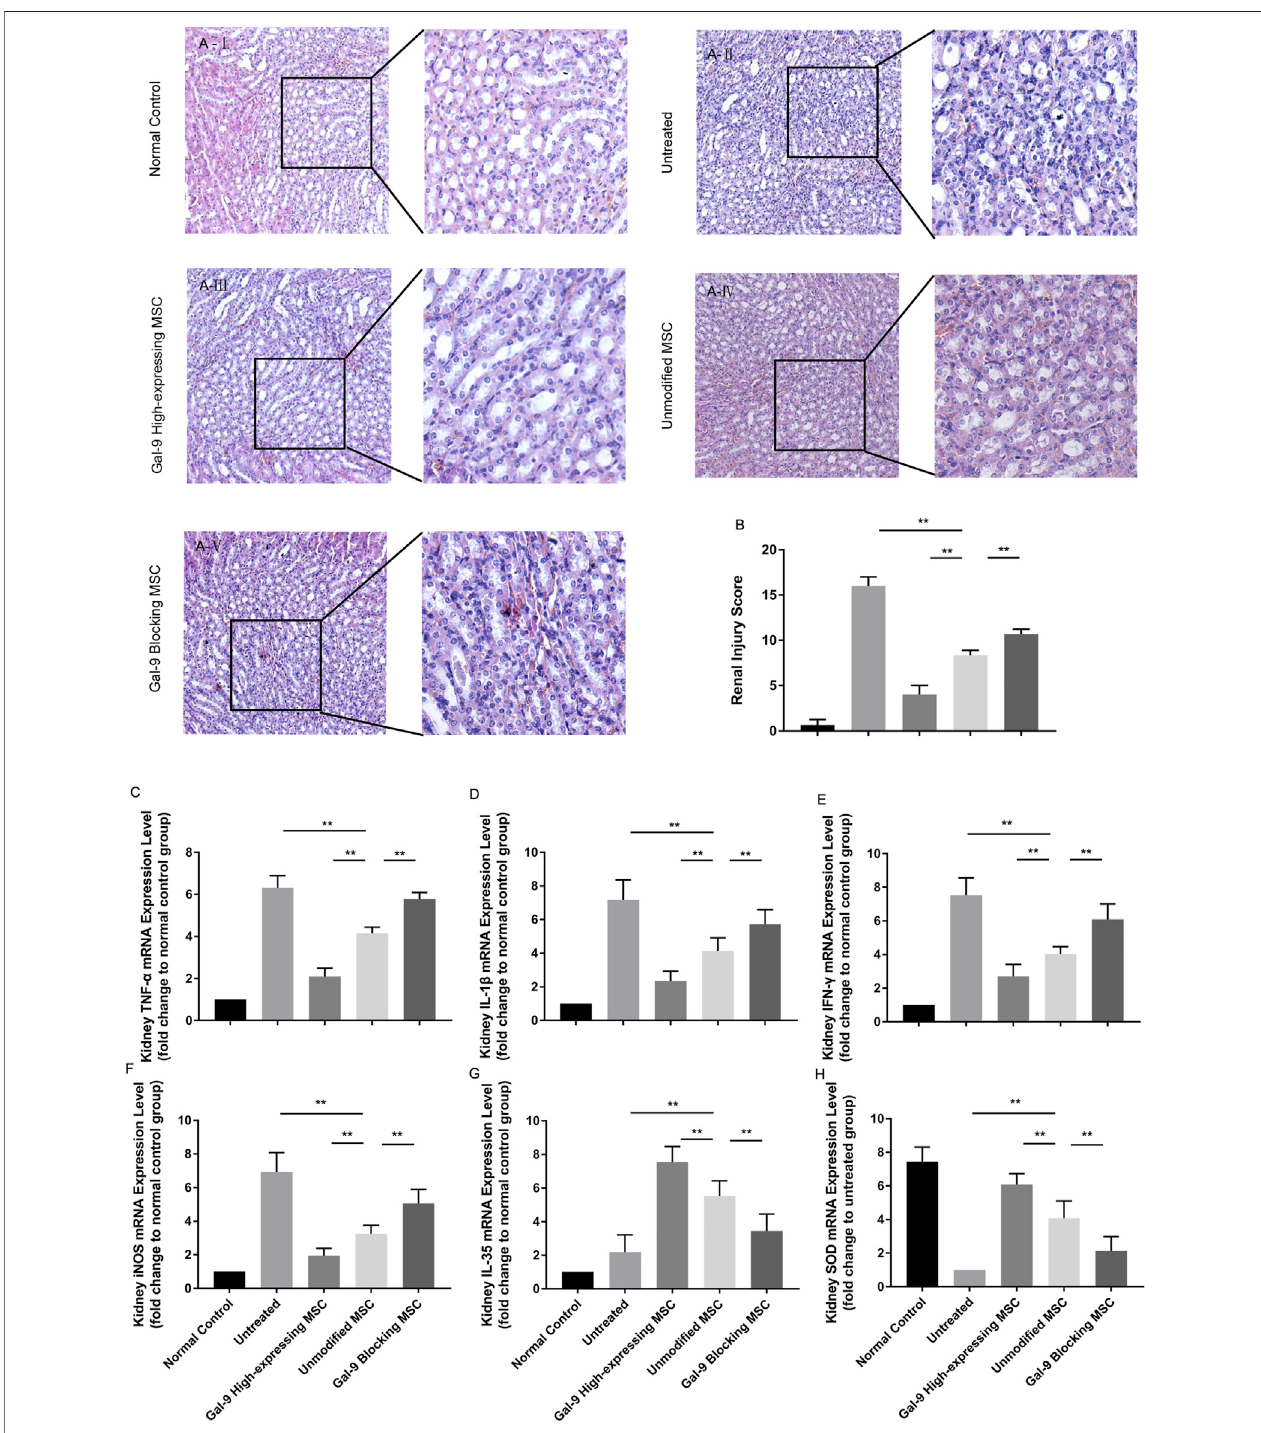
FIGURE 6 | Gal-9 Plays a role in MSC-mediated therapy in lightening renal damage. (A) Representative histological sections of mouse kidney in each group (H&E, 100 × magni fi cation). To speci fi cally observe the difference, a selected small square area was magni fi cently displayed on the right side (200 × magni fi cation). (B) Renal injury score. Criteria for assessing kidney injury are as follows: tubular dilatation/ fl attening, tubular casts, and tubular degeneration/vacuolization (cortex and medulla, 0 – 3,total: 0 – 18). (C – H) mRNA expression levels ofTNF- α (C) ;IL-1 β (D) ;IFN- γ (E) ; iNOS (F) ; EBI3(IL-35) (G) ;SOD (H) .Datavariance wasassessed byusing one- wayanalysisofvariance (ANOVA), followed byleastsigni fi cantdifference (LSD)test, n =6.* p < 0.05, ** p < 0.01.Abbreviations: EBI3,Epstein-Barr virus-induced gene3; iNOS, inducible nitric oxide synthase; SOD, superoxide dismutase.